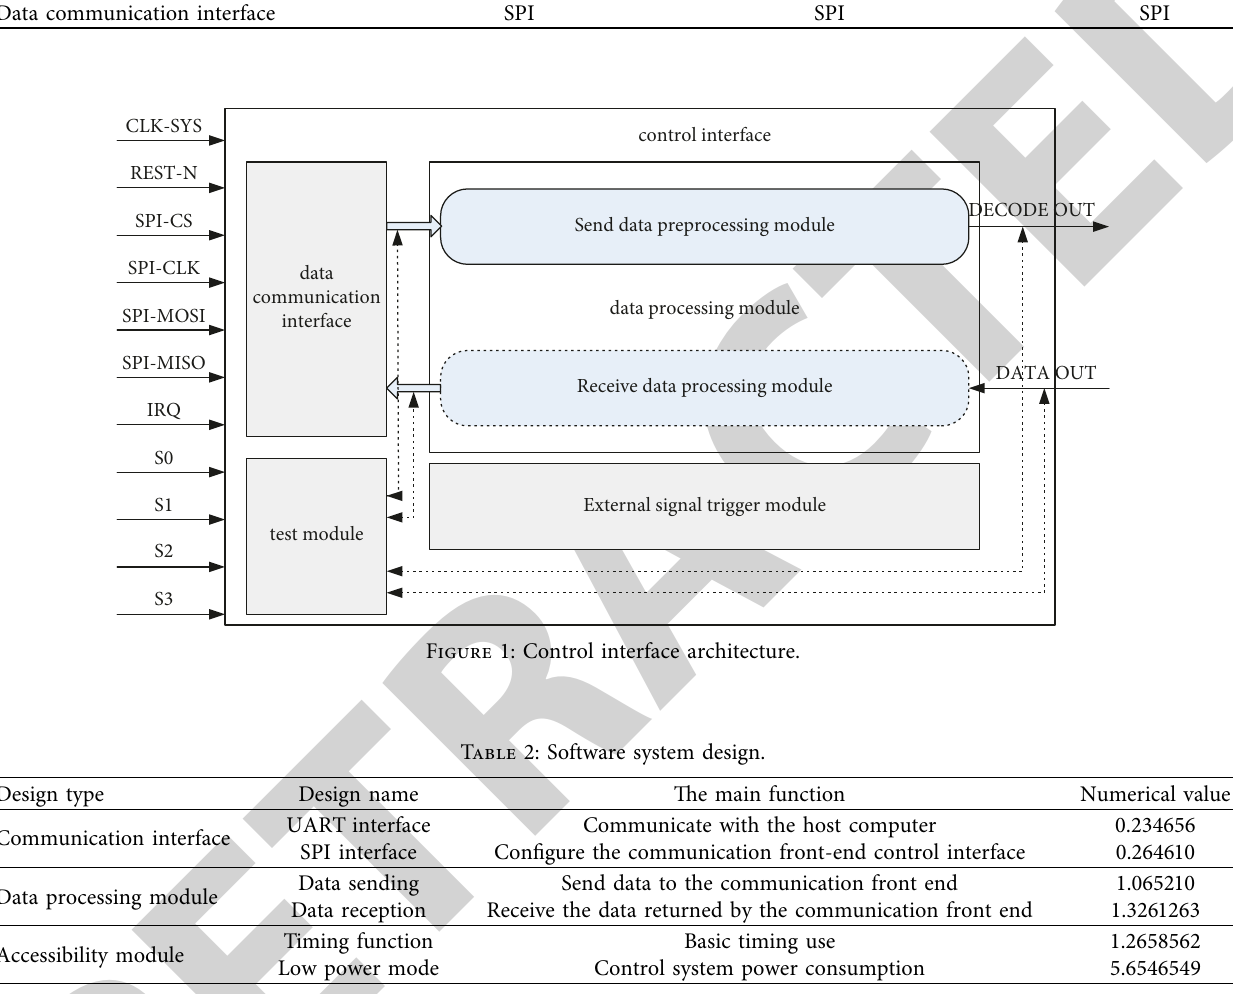
Figure 1: Control interface architecture.